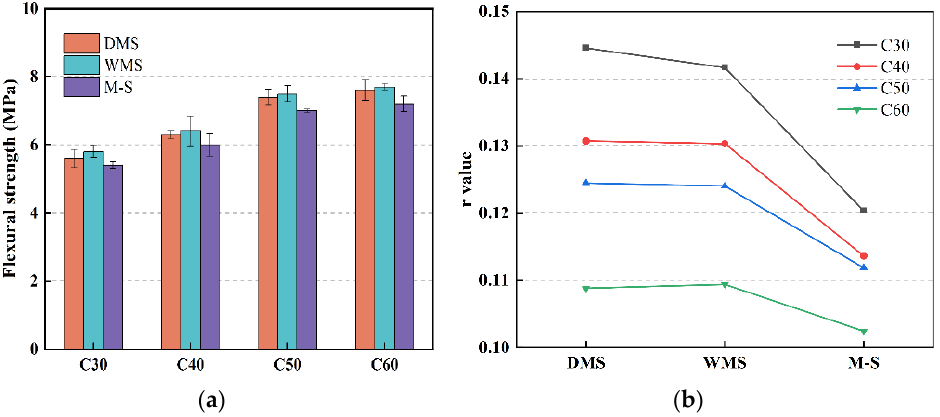
Figure 11. Flexural strength and r value of each group: ( a ) 28-d flexural strength; ( b ) comparison of the r value in different fine aggregates.